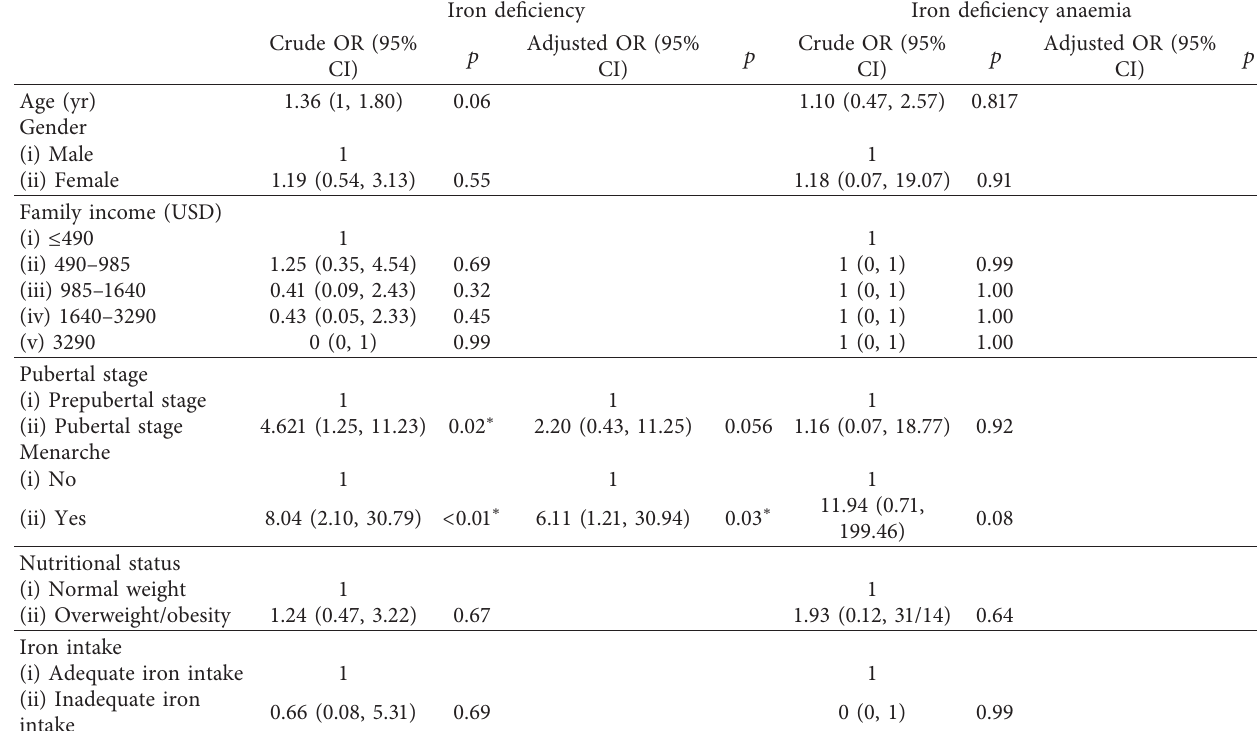
Table 4: The predictors of iron deficiency and iron deficiency